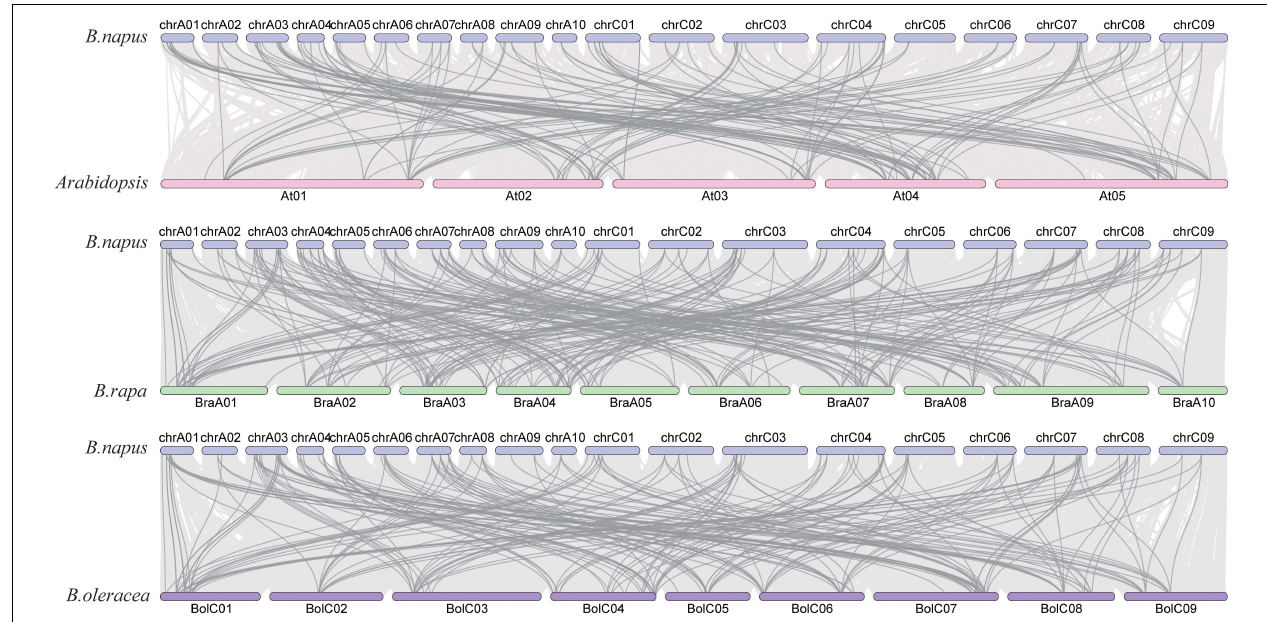
FIGURE 5 | The collinear relationship of AHLs on chromosome. The blue, pink, green, and purple bars represent the chromosomes of B. napus , Arabidopsis , B. rapa , and B. oleracea , respectively. The gray lines in the background indicate the collinear blocks in the genomes of B. napus and Arabidopsis , B. rapa , and B. oleracea , while the darker colored lines emphasize the segmental duplication of the AHLs .